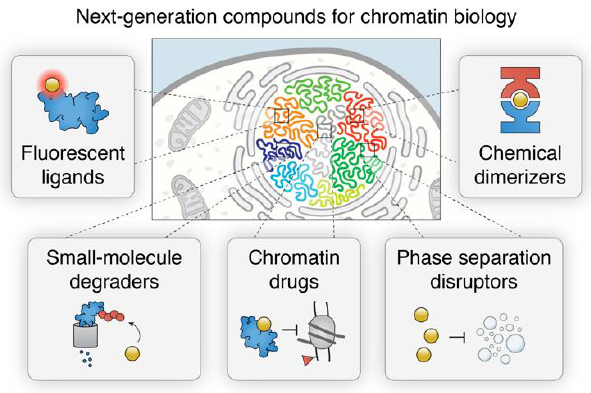
Figure 1. The chemical biology toolkit for investigating chromatin. New developments in chemical biology have yielded powerful new molecules to probe chromatin structure and dynamics.